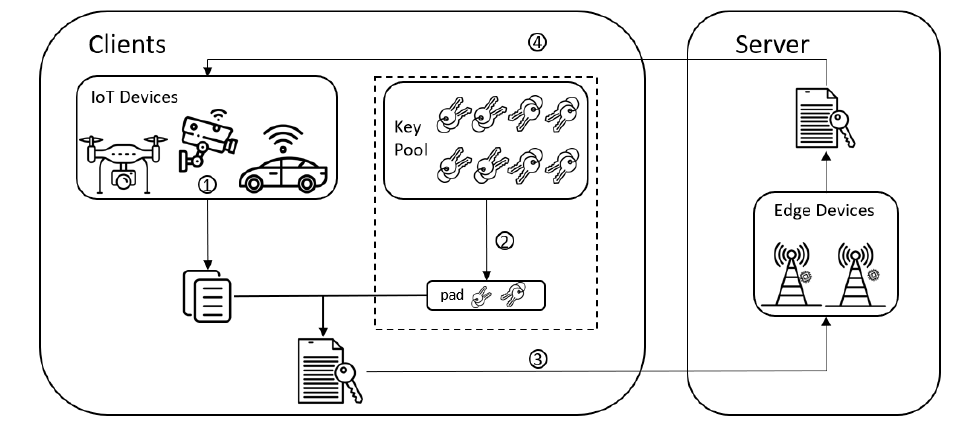
Figure 3. High-level workflow of iPPSP primitive.